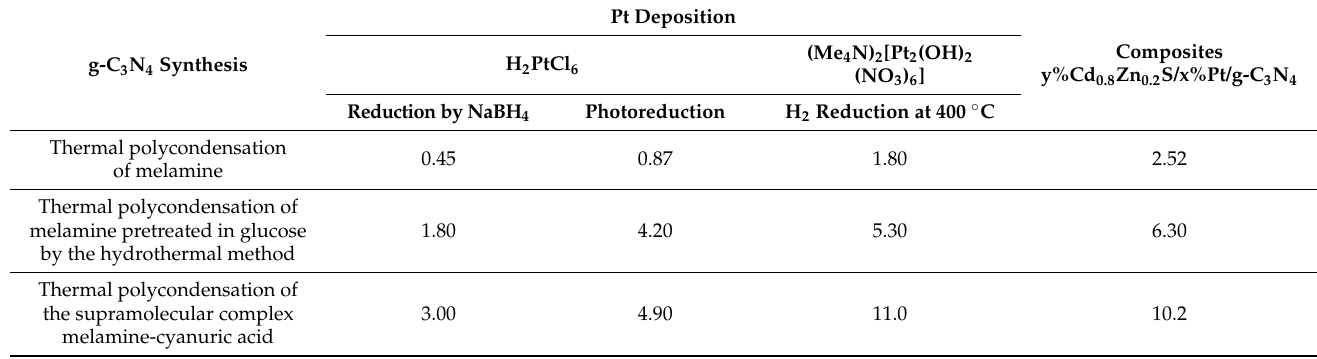
Table 1. Comparison of catalytic activities of various photocatalysts described in Chapter